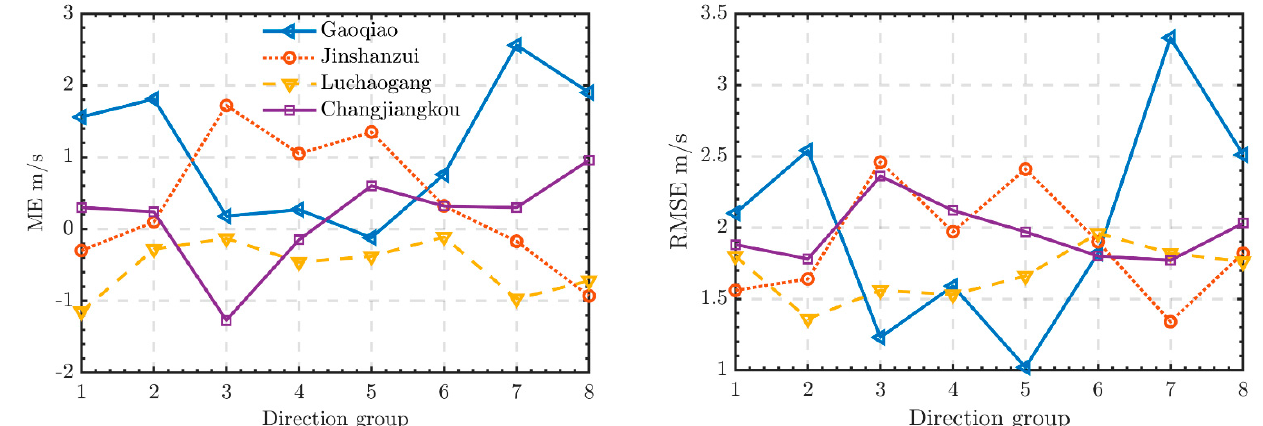
Figure 5. MEs and RMSEs in different directions at different stations. 1–8 represent N–NE,